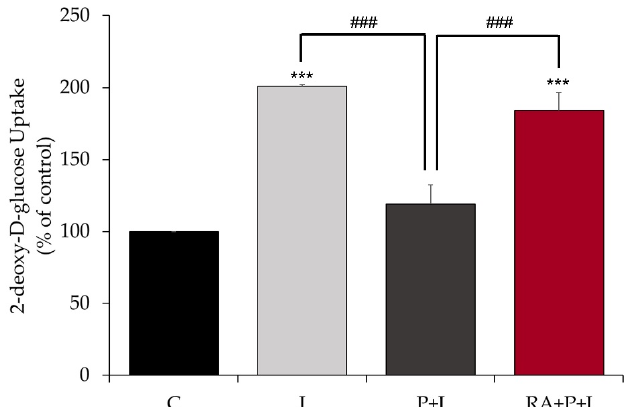
Figure 4. Rosmarinic acid restores the insulin-stimulated glucose uptake in palmitate-treated muscle cells. Fully differentiated L6 myotubes were treated without (control, C) or with 0.2 mM palmitate